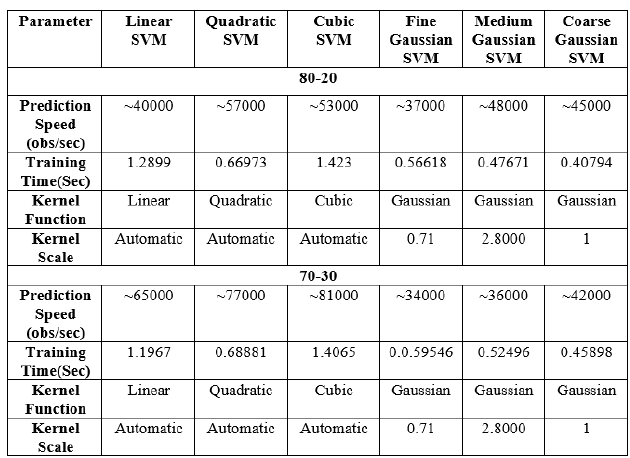
Table 4. Configuration and complexity in 80-20 & 70-